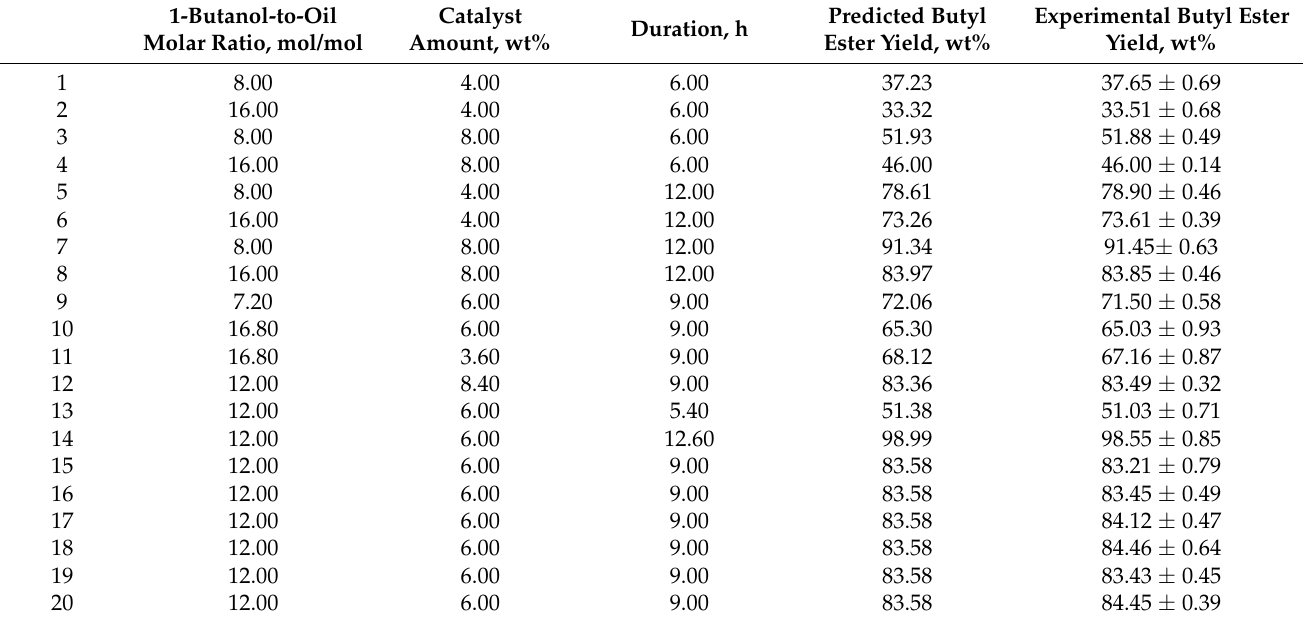
Table 1. Experimental plan, and modelled and experimental results.